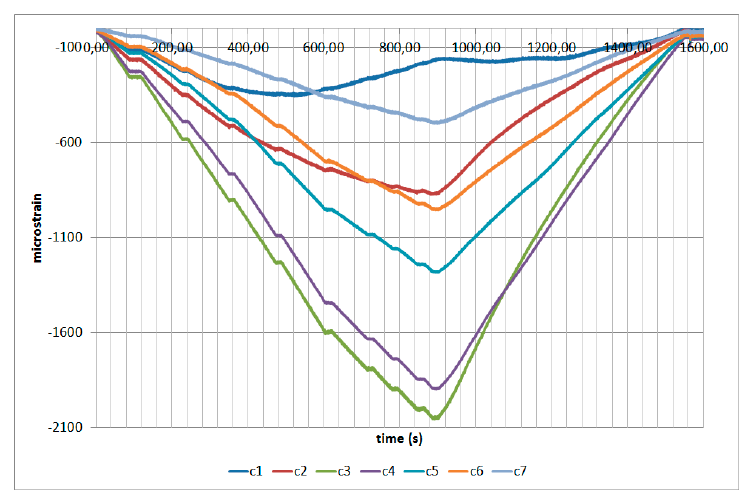
Figure 14. Specimen 1-Root joint -After fatigue -compression UL- Channel C.